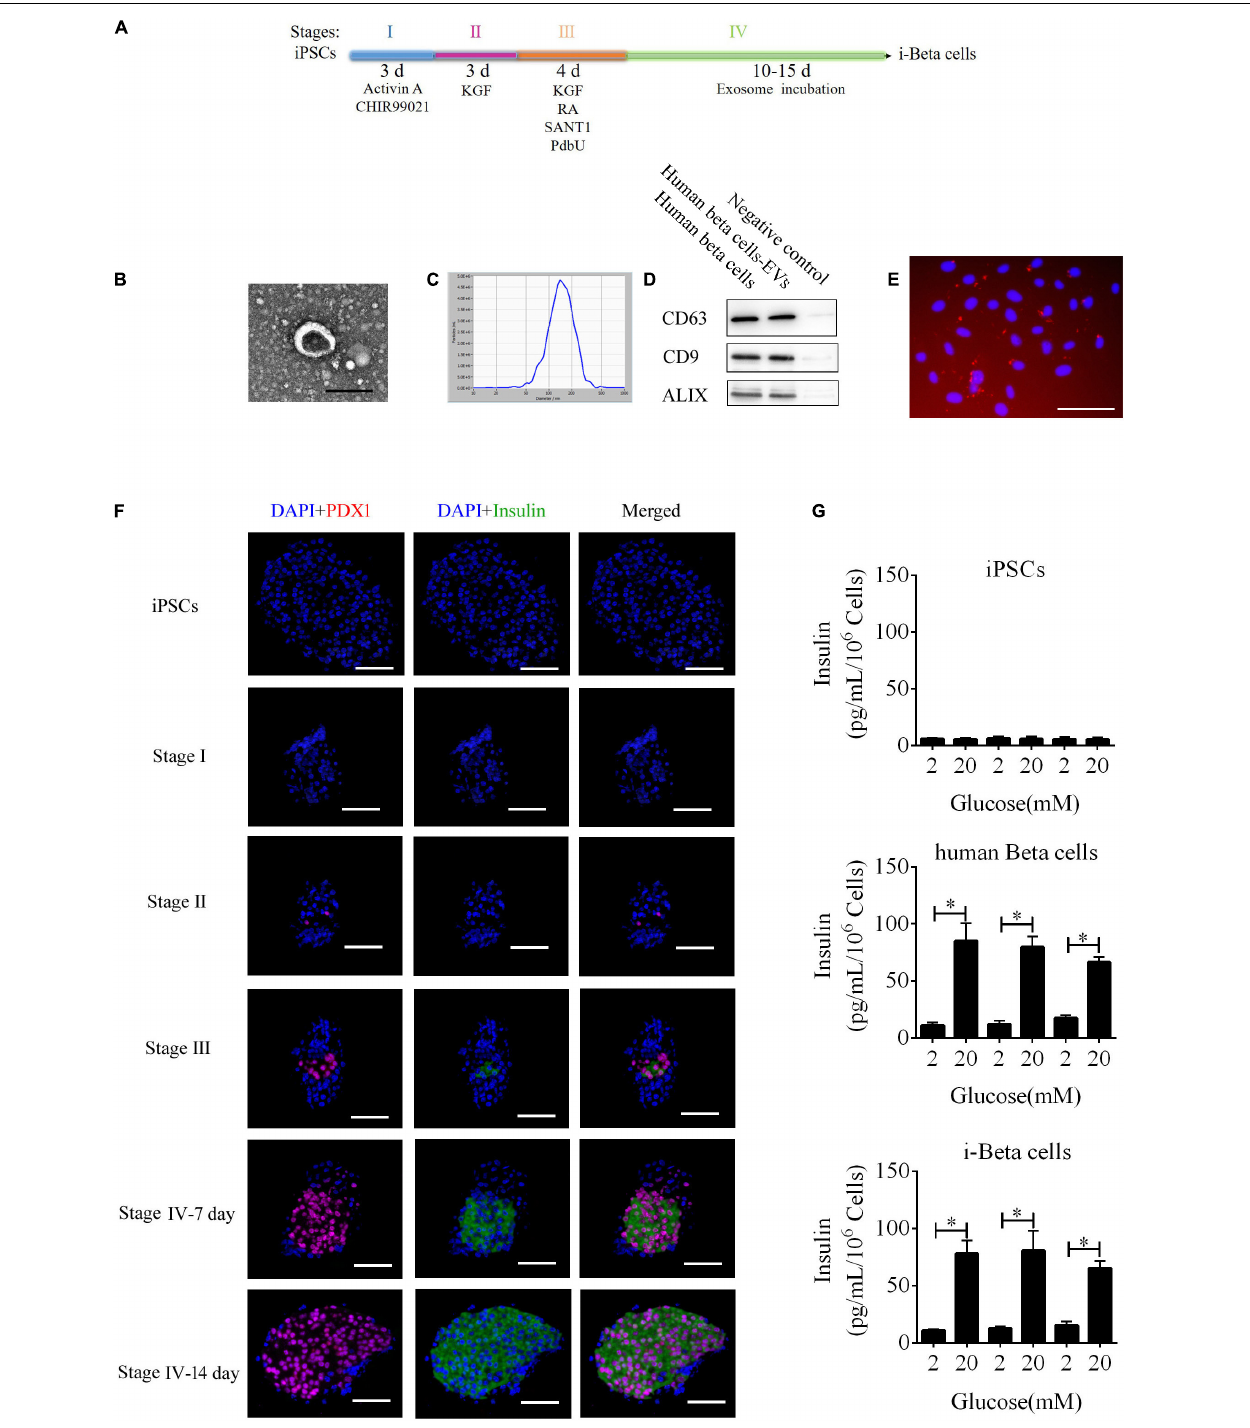
FIGURE 1 | i-Beta cell differentiation from iPSCs using extracellular vesicles. (A) Schematic strategy for differentiation of iPSCs into i-Beta cells. EVs: extracellular vesicles derived from human beta cells. (B) Visualization of EVs from human beta cells by electron microscopy. Scale bar = 100 nm. (C) Size distributions of EVs from mature human beta cells. (D) Western blot analysis of EVs markers CD63, CD9, and ALIX. (E) Differentiated iPSCs were incubated with Dil-labeled EVs for 72 h and then red EV signals were detected by confocal microscopy. Scale bar = 100 µ m. (F) Immunofluorescence microscopy was used to determine expression of PDX1 and Insulin during each stage of differentiation. Scale bar = 100 µ m. (G) Glucose-stimulated insulin secretion of iPSCs, human beta cells, and i-Beta cells. An ELISA was used to measure secreted human insulin from cells stimulated sequentially with 2, 20, 2, 20, 2, and 20 mM glucose with 30 min of incubation at each concentration. Insulin was secreted from human beta cells and i-Beta cells but not iPSCs. * p < 0 . 05, ** p < 0 . 001.